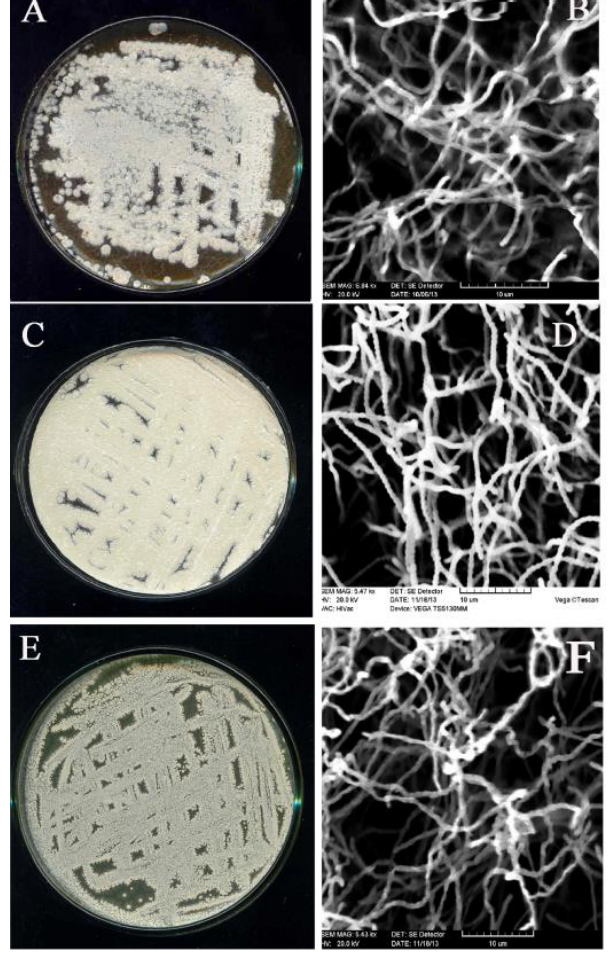
Figure 10. Pure culture of potential antagonists and findings of scanning electron micrographs. ( A ), ( B ) isolate 5, ( C , D ) isolate U, and ( E , F ) isolate G.